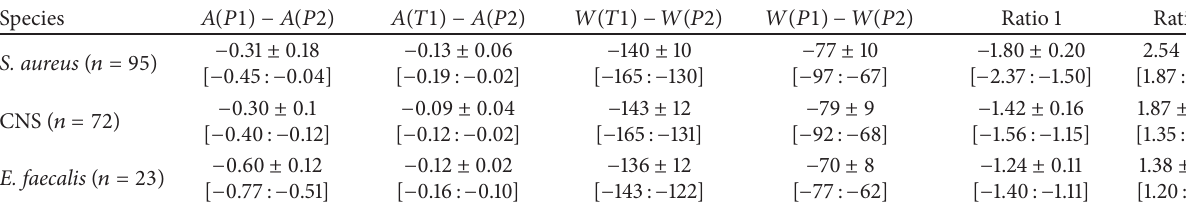
Table 3: The mean ( ± 2 SD) and range values of the characteristics of the multiwavelength angular scattering spectra of S. aureus , CNS, and E. faecalis training sets.